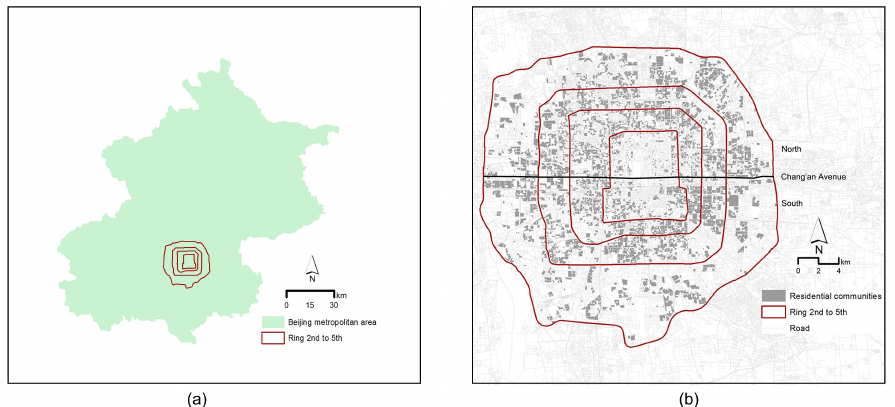
Figure 1. ( a ) The built-up area within the 5th Ring Road of Beijing as the study area; ( b ) 4544 residen- tial communities in the study area as the analysis